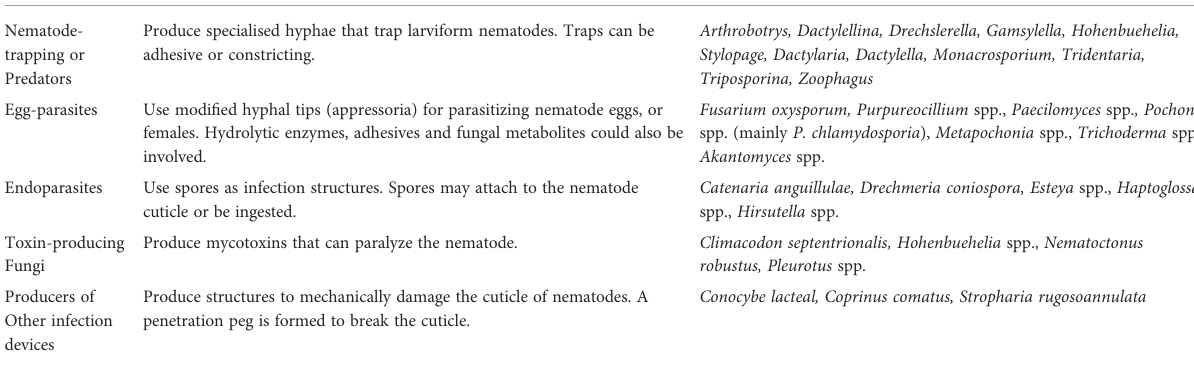
TABLE 1 Groups of Nematophagous